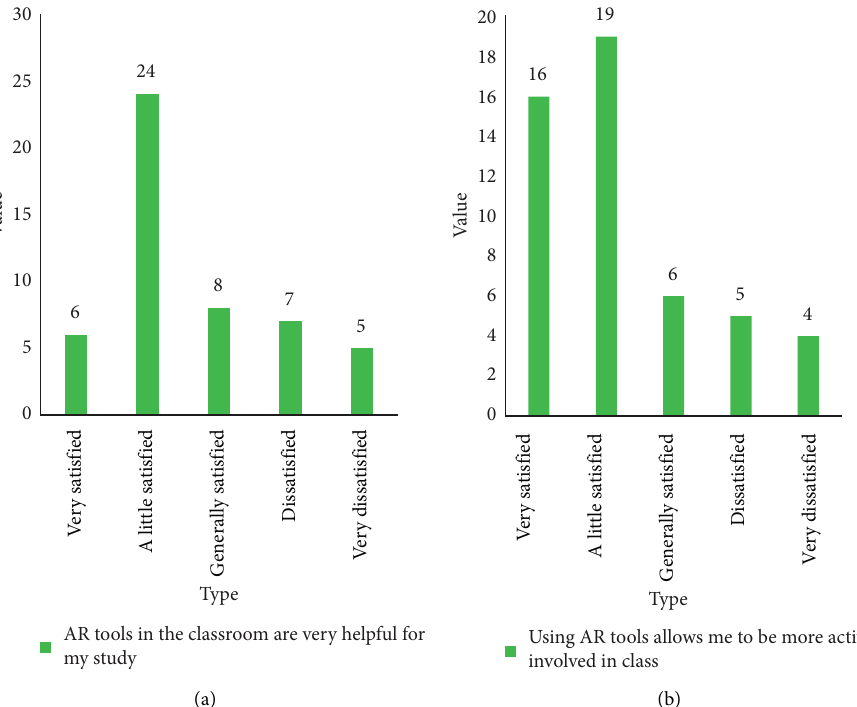
Figure 6: AR tool perceived usefulness statistics. (a) AR is helpful for self-learning. (b) After using AR, self-participation in classroom activities is more